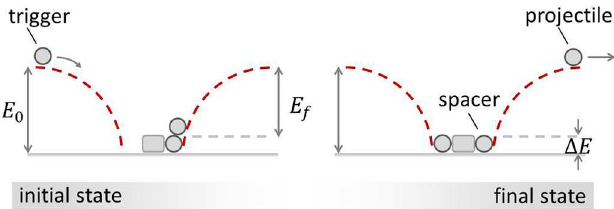
Fig. 3. Mixed metaphor diagram illustrating the process by which the projectile ball gains a kinetic energy ∆ E over the initial kinetic energy of the trigger ball.